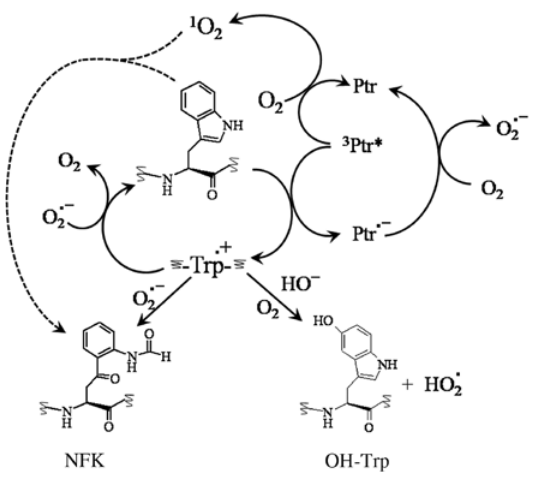
Scheme 2: Main reaction pathways proposed for the Ptr photosen- sitized degradation of the Trp residue in